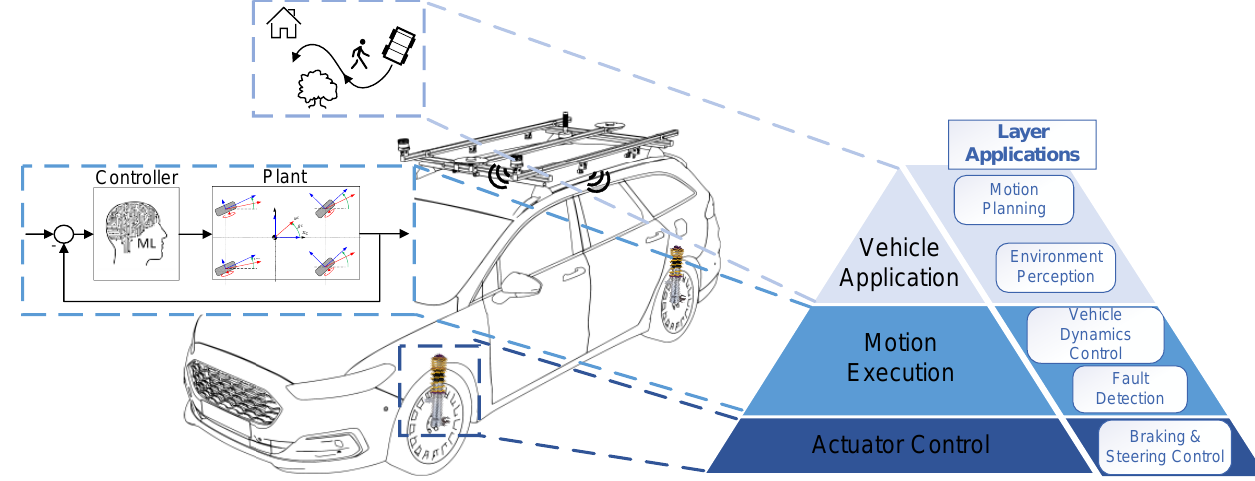
Figure 2. The DLR-SR scalable vehicle dynamics control architecture and its applications, fully addressed by the AFM, extended from